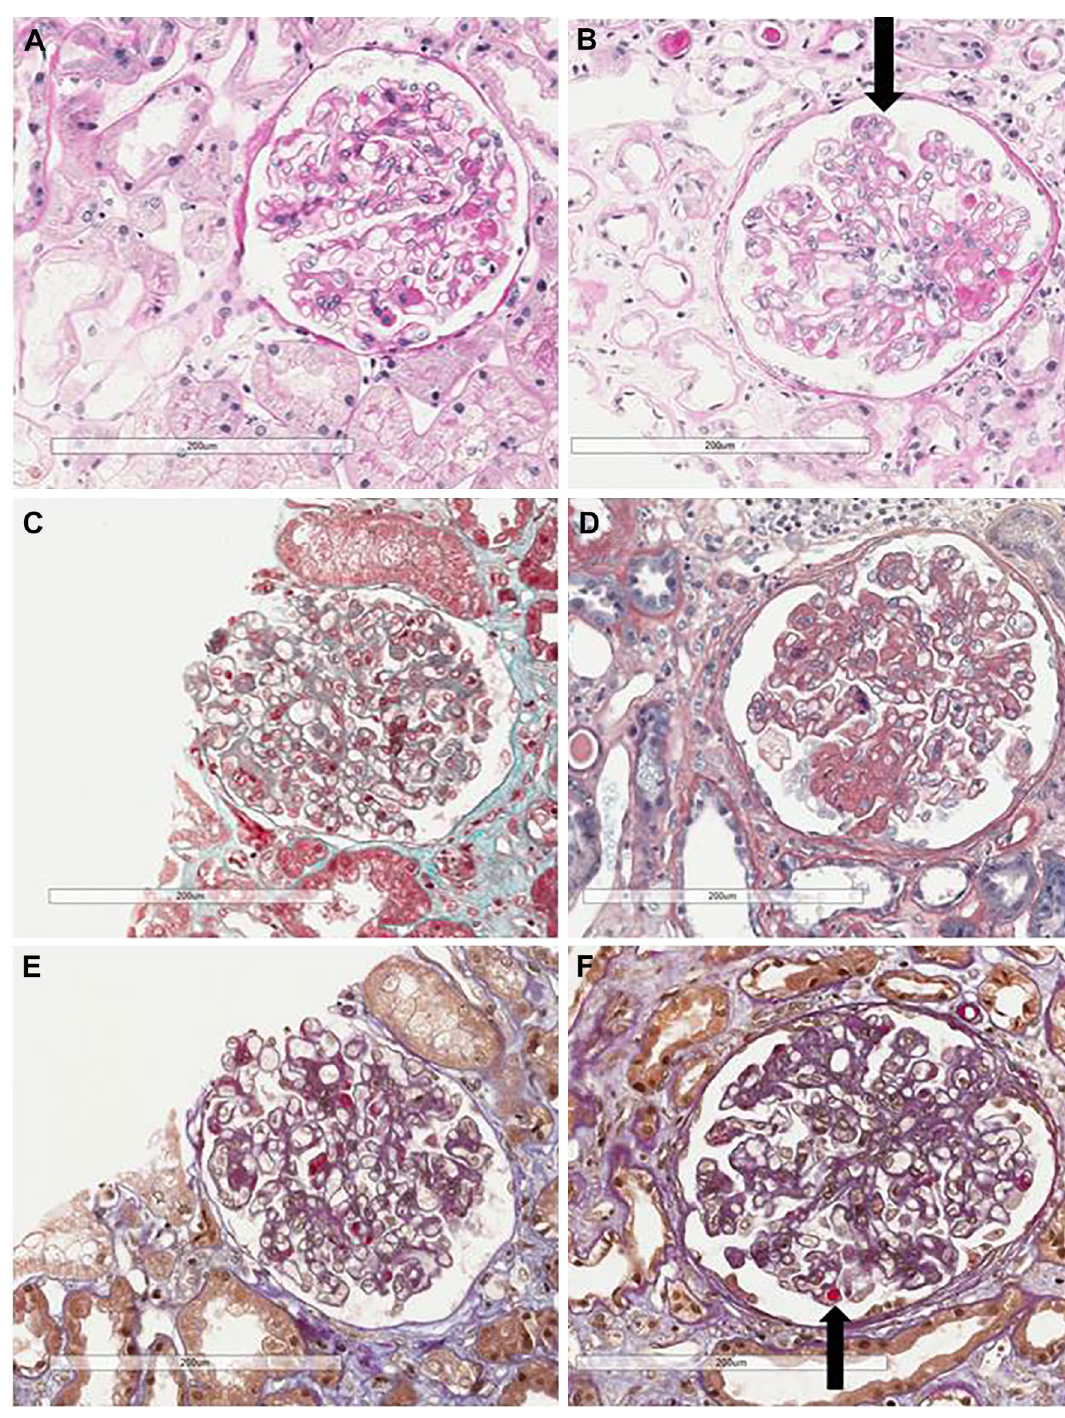
Figure 1. Light microscopy findings in hypocryoglobulinaemic glomerulonephritis. ( A – C ) PAS and Trichrome stains show mild thickening of basement membranes with segmental duplication (arrow in B ), mild mesangial hypercellularity and increased matrix and eosinophilic refractile pseudothrombi ( A , B ), PAS original magnification × 200; ( C ) trichrome original magnification × 200. ( D – F ) Pseudothrombi appear respectively blue on PTAH stain and glassy pink (arrow in F ) on AFOG sections ( D , PTAH original magnification × 200; E , F , AFOG original magnification ×